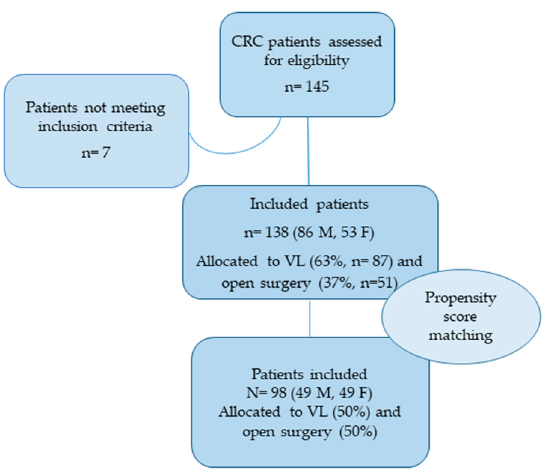
Figure 1. Study flowchart. Abbreviations: Colorectal Cancer (CRC); Video-Laparoscopic Surgery (VL).